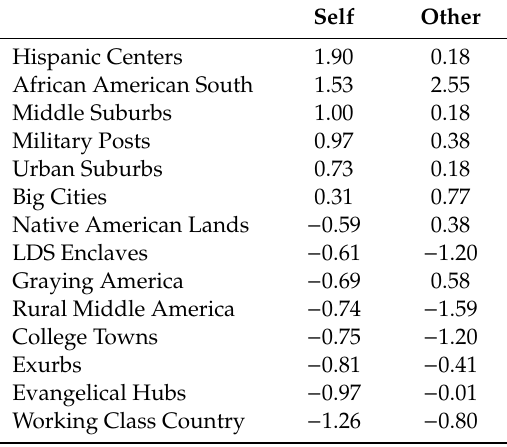
Table 2. Standardized (z scored) relative frequency of “I ” and “he / she / they ” within drunk